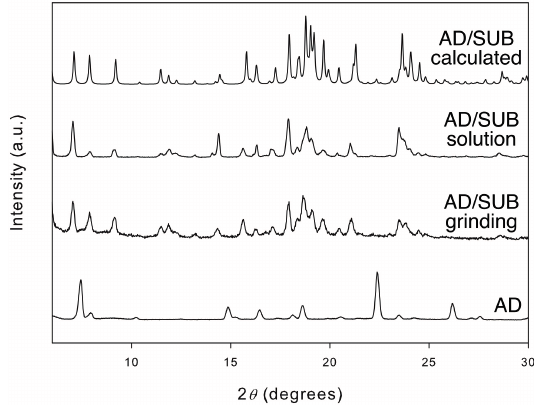
Figure 4. XRD patterns of neat AD and AD/SUB cocrystals. The pattern of the